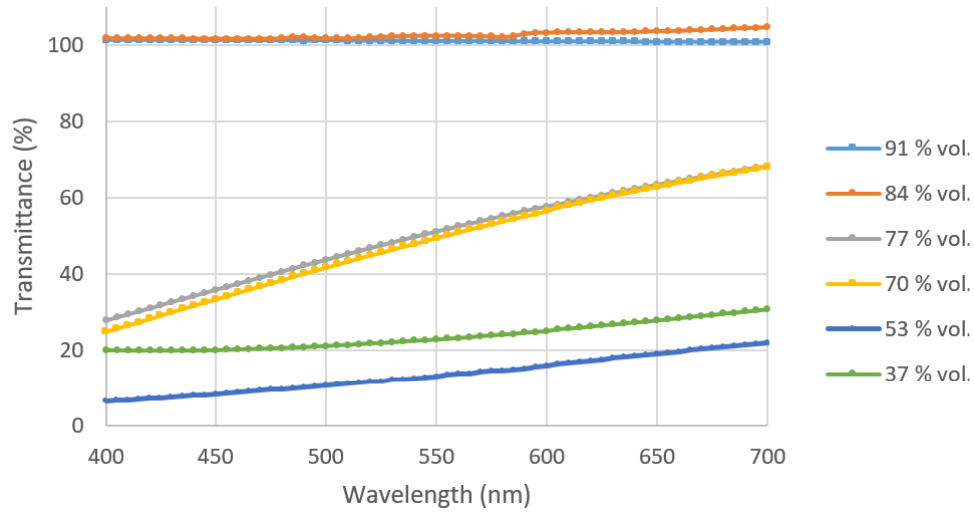
Figure 11. The transmittance (%) versus wavelength graphs of different coatings.